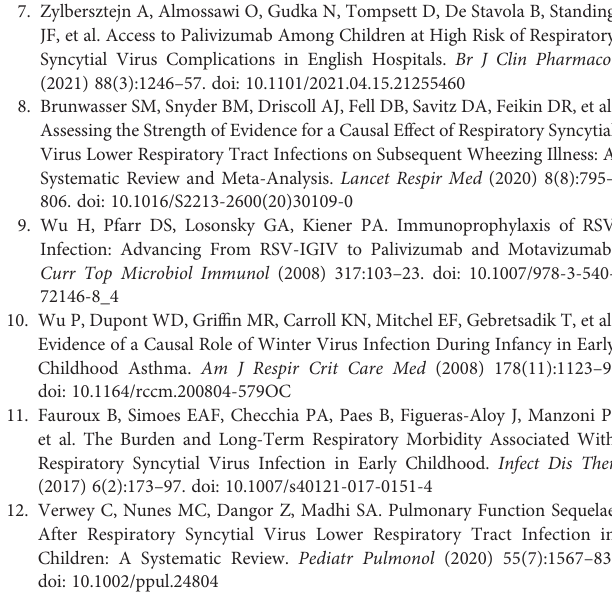
Supplementary Figure 1 | Flow cytometry gating strategy for PBMC studies. PBMCscollectedatage2-3yearswerestimulatedwithclinicalstrainRSVA2001/3- 12 at MOI = 1 for 72 h. Cells were washed, stained for surface markers, fi xed, permeabilized and stained intracellular with fl uorescent-labeled antibodies to detect intracellular IFN- g , TNF- a , IL-2, T-bet, and ROR g t. Percentage of cells expressing these cytokines and transcription factors were determined within CD4 and CD8 memory T cell subsets: TCM, TEM, and TEMRA. CD4 and CD8 memory T cell subsets were gated based on CCR7 and CD45RA expression within CD3 positive cells after consecutive doublet, nonlymphocyte and dead cell exclusion. Gating for cells expressing cytokines or transcription factors was performed using SEB- stimulated same specimen replicates as a positive gate control and gated naive T cell population of the same-specimen replicates as a negative gate control. Supplementary Figure 2 | Representative fl ow cytometry plots of cells expressingcytokineandtranscriptionfactorsinPBMCsafter invitro stimulationwith RSV 3-12. PBMCs collected at age 2-3 years were stimulated with clinical strain RSV A2001/3-12 at MOI =1 for 72 h. Cells were washed, stained for surface markers, fi xed, permeabilized and stained intracellular with fl uorescent-labeled antibodies to detect intracellular IFN- g , TNF- a , IL-2, T-bet, and ROR g t. Percentages ofcellsexpressing thesecytokines andtranscription factorsweredetermined within CD4 and CD8 memory T cell subsets by fl ow cytometry (plots show CD4 and CD8 TEM